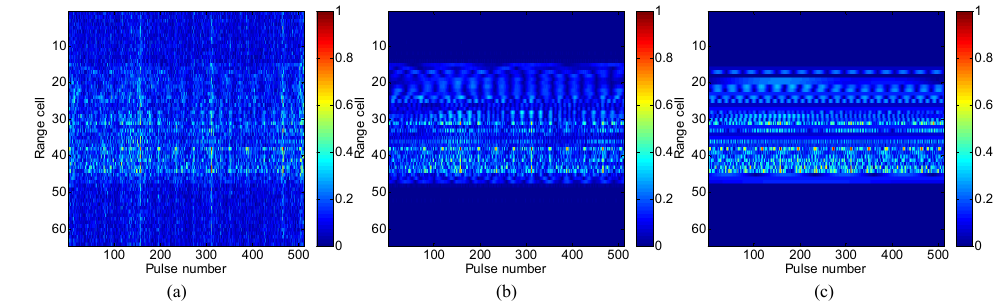
Figure 4. Range profiles of Mig-25 with SNR = 0 dB: ( a ) original; ( b ) the Laplacian prior based Bayesian (LB) method; ( c ) the logarithmic Laplacian prior based Bayesian (LLB)